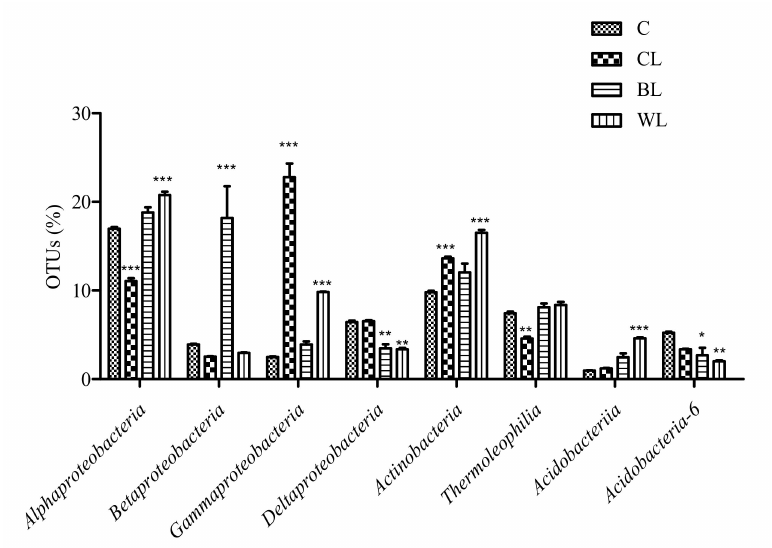
Figure 4. Most abundant identified classes in control soil and lubricant-spiked soils after 40 days of exposure (n = 3, mean values ± s.e.m.). Significant differences at p < 0.05 (*), p < 0.01 (**) and p < 0.001 (***) with respect to control soil are shown.